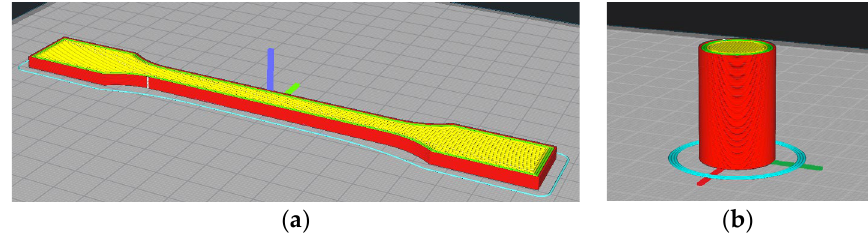
Figure 3. Printing orientation of sliced specimens for tensile ( a ) and compression ( b ) tests. Table 6. IR power sensitivity analysis results.